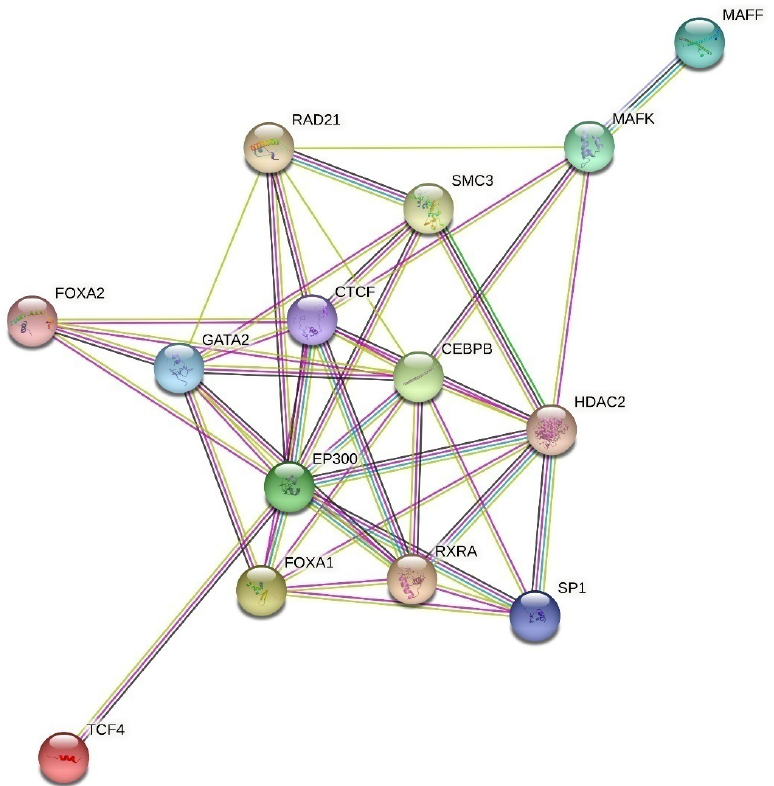
Figure 2. The interatomic network of the regulatory proteins involved in endometriosis inferred using STRING (https://string-db.org/ (accessed on 15 July 2022)).